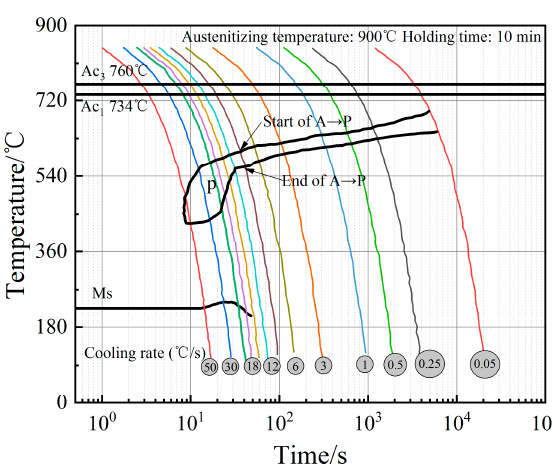
Figure 2. CCT curve of 65Mn low-alloy steel.